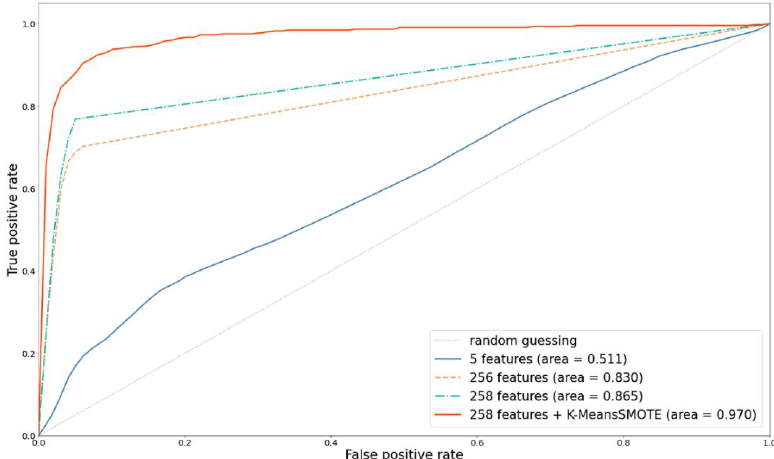
Figure 8. Comparison of ROC curves with different feature extractors.